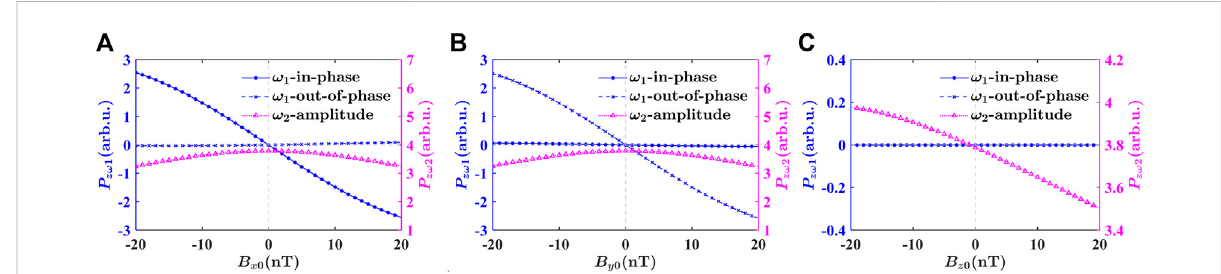
FIGURE 2 Simulateddependence of thein-phase and out-of-phasesignal of P z ω 1 and theamplitude of P z ω 2 on: (A) the variation of B x 0 within the range of [-20,20] nT; (B) the variation of B y 0 within the range of [-20,20] nT. (C) The variation of B z 0 within the range of [-20,20] nT.